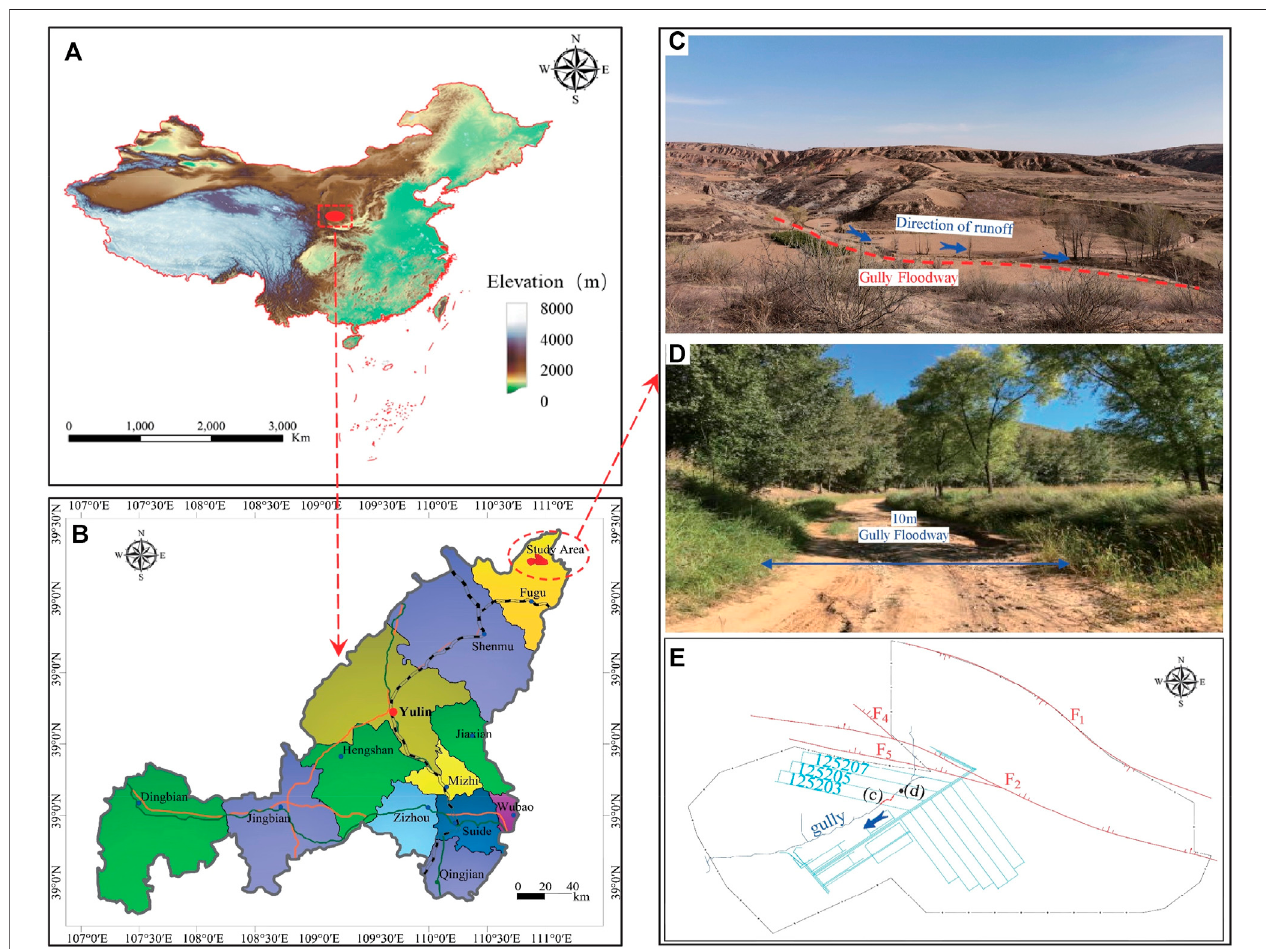
FIGURE 1 | Location and topography of the working face in the study site. (A) Location of study area in China; (B) Location of study area in Yulin, China; (C) Site map of gully morphology; (D) Site map of gully fl oodway.